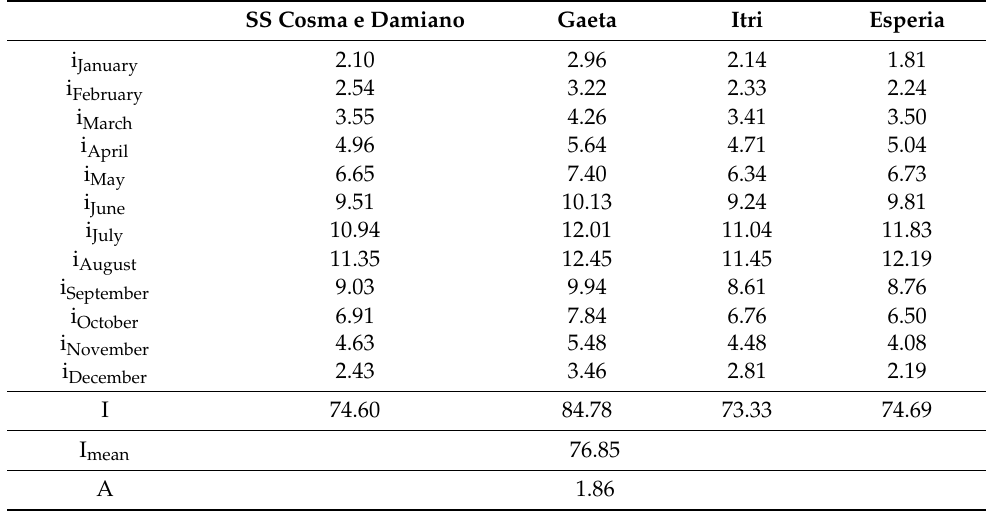
Table 2. Monthly Thornthwaite heat index (i), annual heat index (I), annual mean heat Index (Imean) and α coefficient for Capodacqua di Spigno basin. SS Cosma e